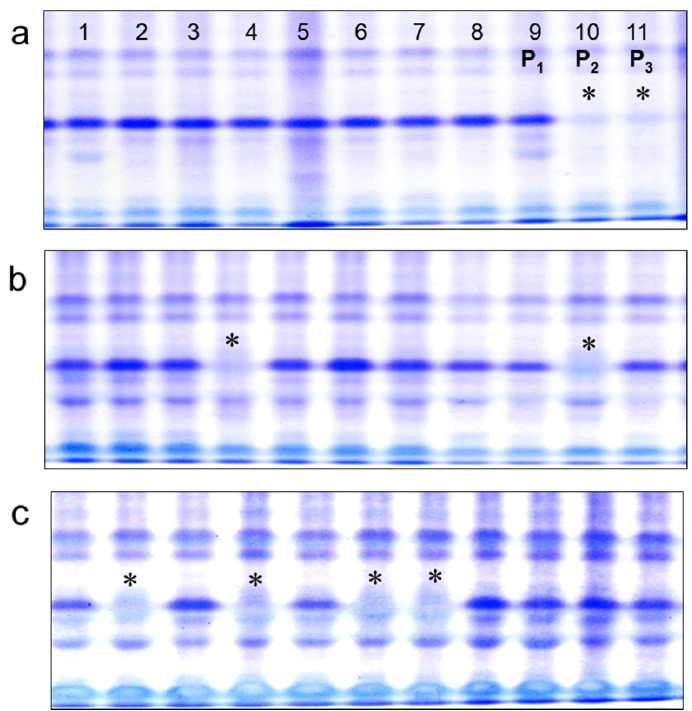
Figure 3. Polyacrylamide gel patterns of soybean seed storage proteins: ( a ) local varieties (1–8) and (9) parental cultivar Lastochka (P 1 ) with genotypes Ti3/Ti3 ; two other parental forms (10 and 11), Ascasubi (P 2 ) and Hilario (P 3 ), respectively, with genotype ti3/ti3 . Examples of the F 2 segregating populations: ( b ) Lastochka × Ascasubi; and ( c ) Lastochka × Hilario. Homozygote genotypes, ti3/ti3 , are indicated by asterisks (*).